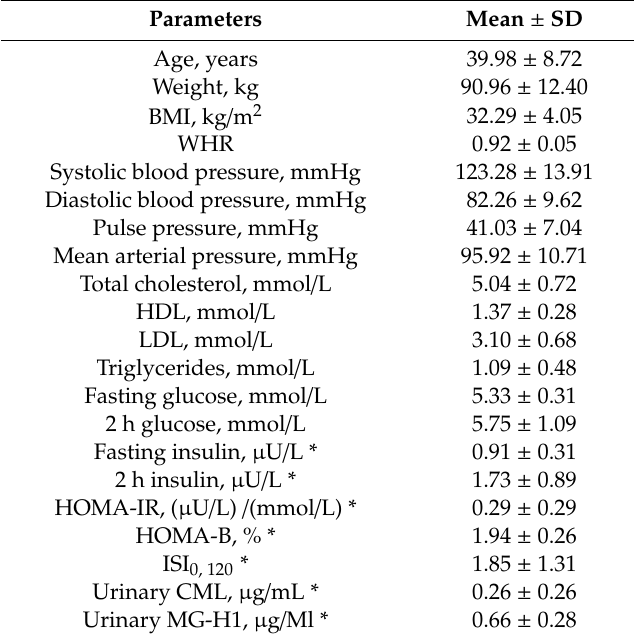
Table 1. Participant characteristics.